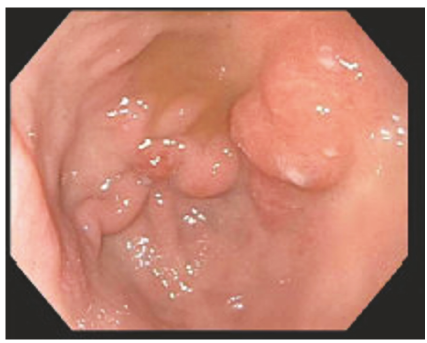
Figure 2: Nonbleeding gastric